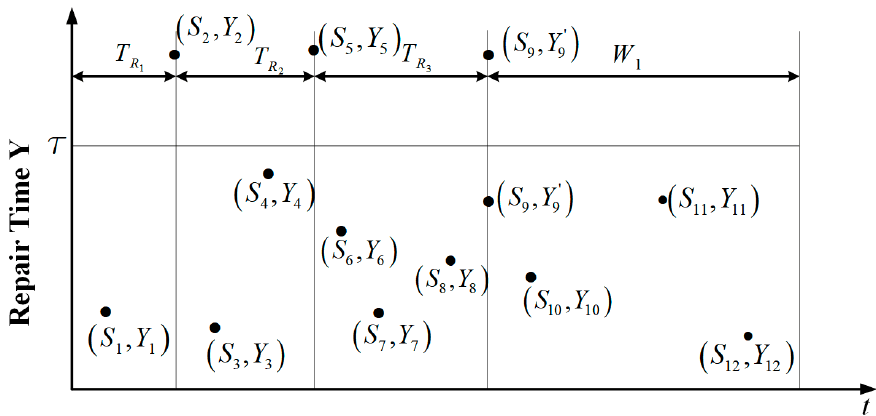
{ , } N t { τ , N } model. Figure 1. A possible product state evolution path under